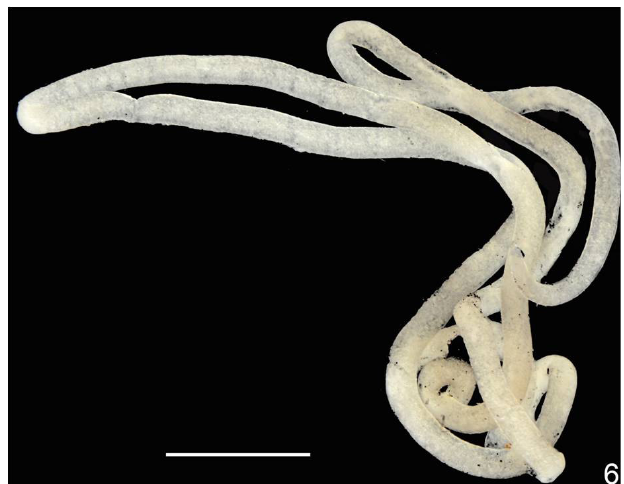
Fig 6 . Mermithid nematode prepared from abdomen of